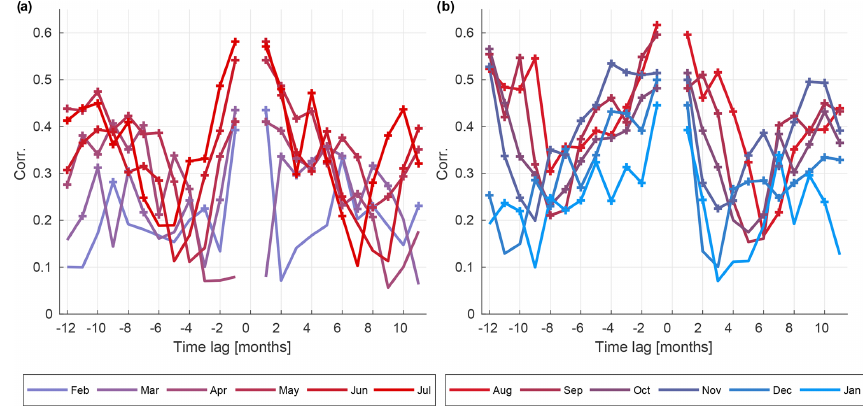
Figure 2. Autocorrelation analysis for PC1 of monthly 20CR SLP (1851–2010). Panel (a) shows results for February–July, and (b) shows August–January. The symbol ” + ” indicates significant correlations ( p < 0 .